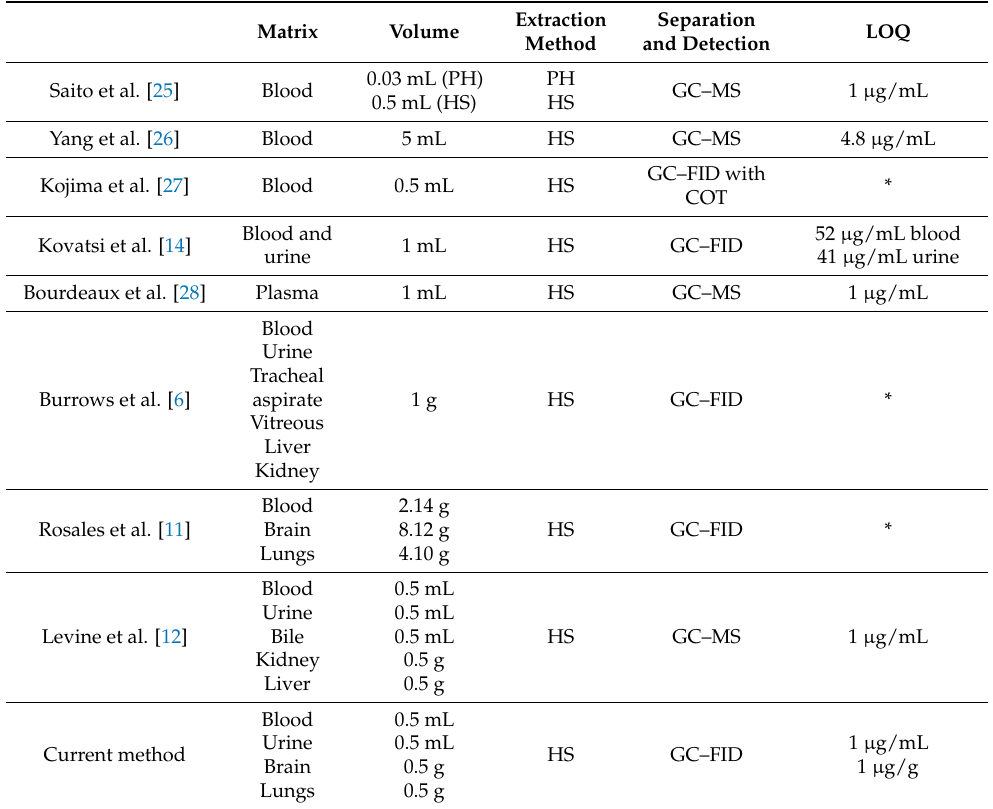
Table 3. An overview of the published methods for the detection of sevoflurane in biological